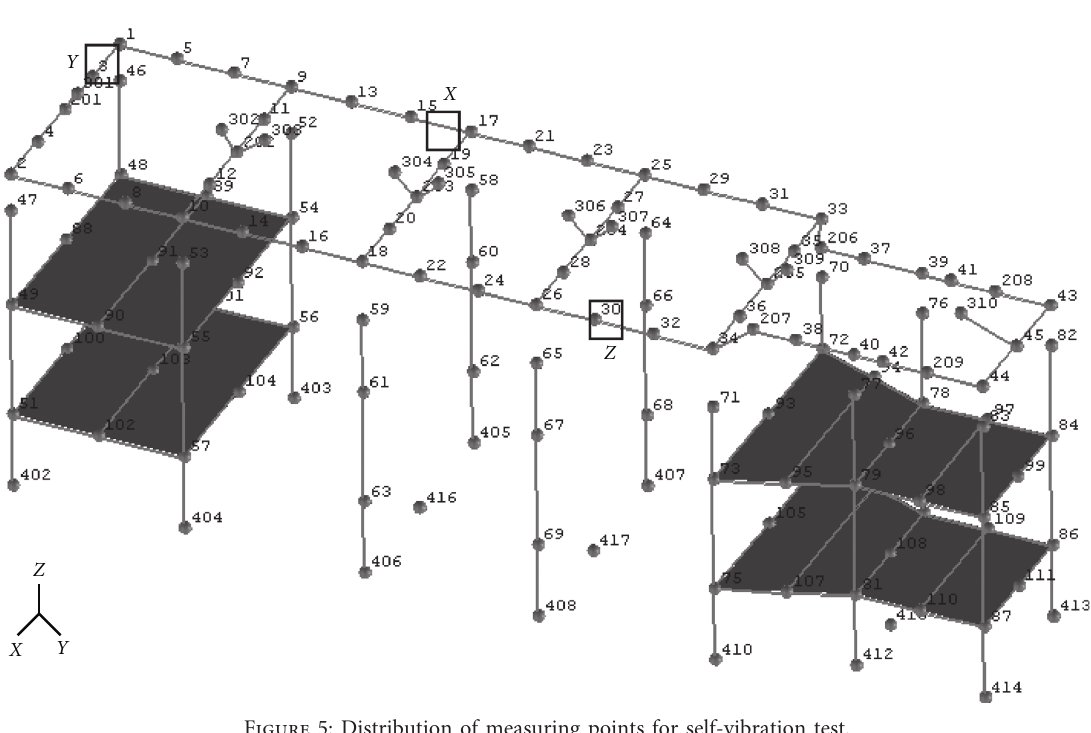
Figure 5: Distribution of measuring points for self-vibration